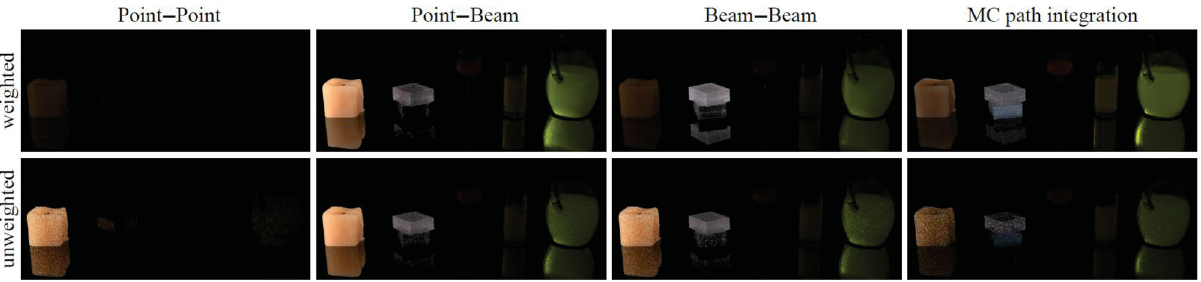
Fig. 3 Contributions of different estimators to the UPBP image of the Still Life scene. Reproduced with permission from Ref. [1], c (cid:2) ACM 2014.